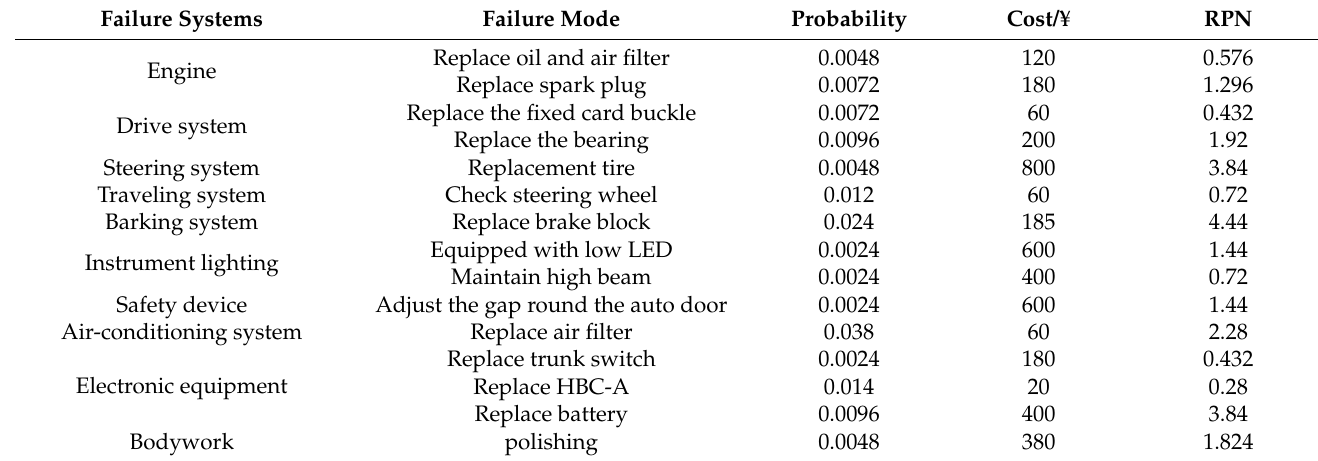
Table 4. Part of the results of